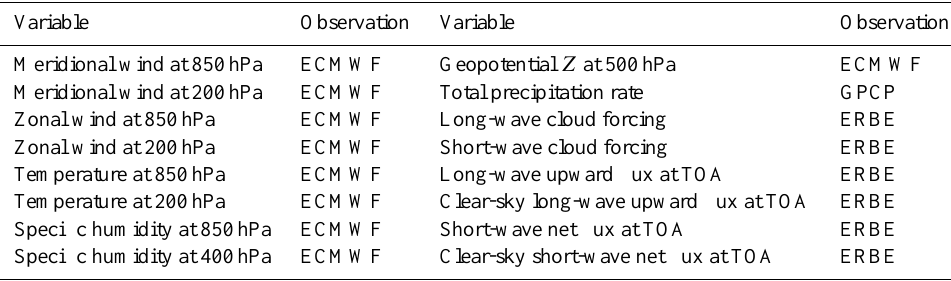
Table 2. Atmospheric fields included in the evaluation metrics and their